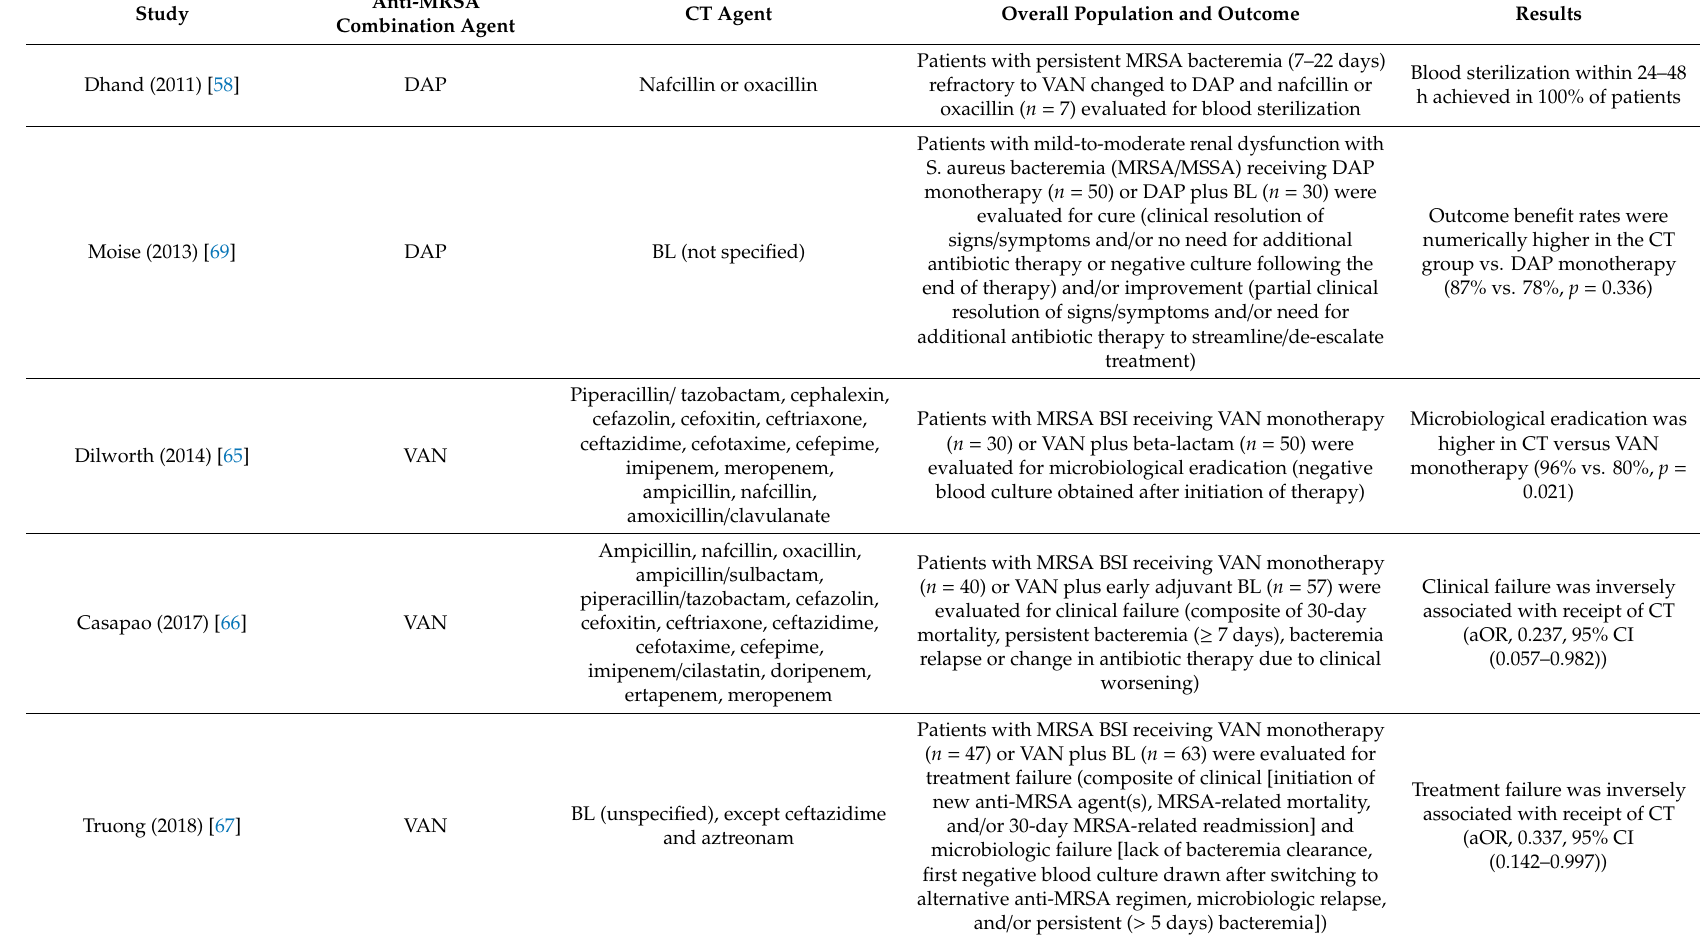
Table 1. Clinical Outcomes of Glycopeptides in Combination with Beta-Lactams from Selected